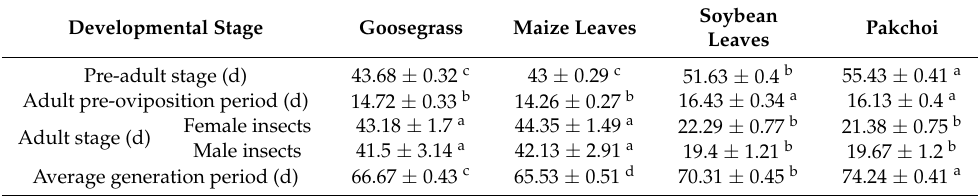
Figure 1. Food utilization efficiency by Locusta migratoria manilensis (Meyen) reared on four food plants. AD, ECI, and ECD indicated approximate digestibility (means ± SE), efficiency of conversion of ingested food (mean ± SE) and efficiency of conversion of digested food (mean ± SE), respectively. Significant differences within AD, ECl, and ECD are indicated by lowercase letters (ANOVA, p < 0.05), respectively. Table 2. Developmental durations of L. migratoria manilensis reared on four food plants.